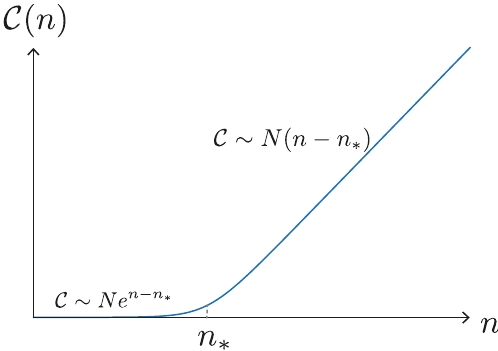
Fig. 5 Illustration of the time dependence of complexity of the precur- sor. An initial exponential regime is followed by linear growth starting at the scrambling time n